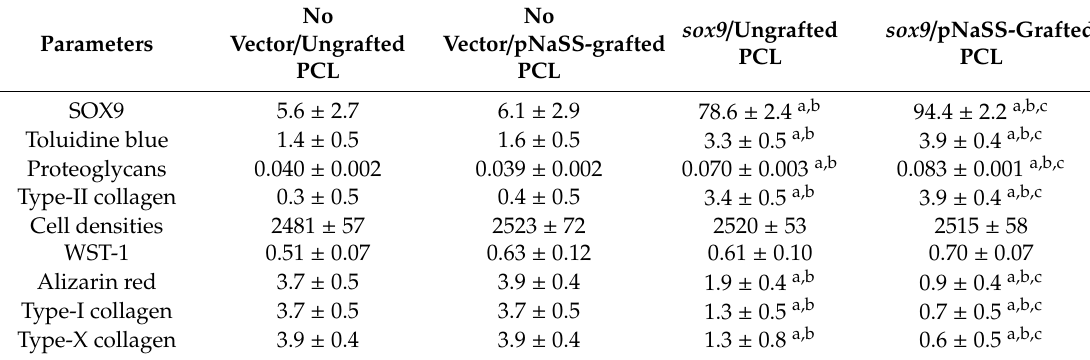
Figure 1. E ff ective sex-determining region Y-type high-mobility group box 9 (SOX9) overexpression in human bone marrow aspirates transduced with recombinant adeno-associated virus (rAAV) sox9 -coated poly( ε -caprolactone) (PCL) films. poly(sodium styrene sulfonate) (pNaSS)-grafted and ungrafted PCL films were coated with rAAV-FLAG-h sox9 or let without vector treatment prior to incubation with the aspirates and SOX9 expression was immunodetected after 21 days (magnification × 20; all representative data). Table 1. Histomorphometric and biological analyses in human bone marrow aspirates transduced with the rAAV-coated PCL films.